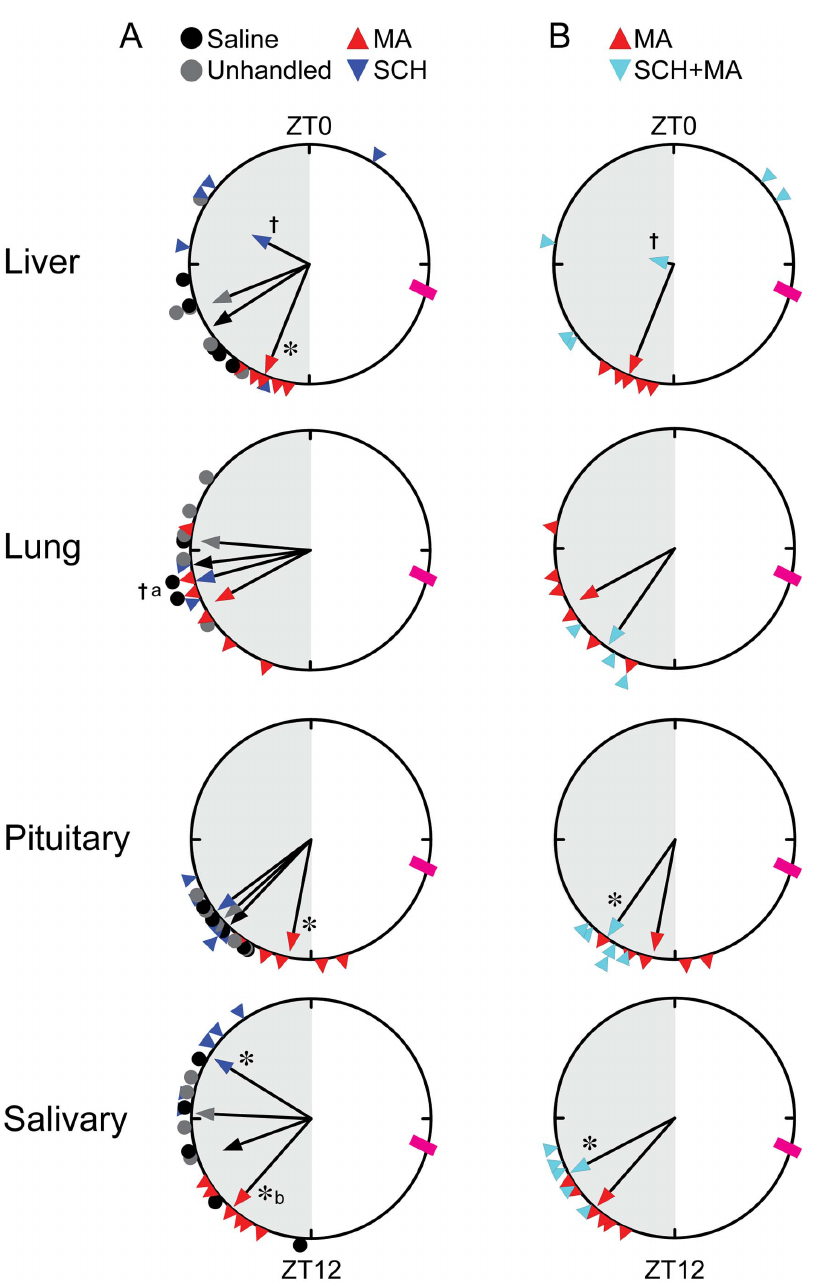
Figure 4. MA and SCH injections affect the phase of PER2::LUC expression in circadian oscillators. Rayleigh plots of the phases of peak PER2::LUC expression in liver, lung, pituitary gland, and salivary gland. Rayleigh plots can be read as a 24h clock, with ZT0 at the top and ZT12 at the bottom of the circle. Arrows represent the average peak phase of PER2::LUC expression (mean vectors for the circular distributions) of each group. The length of the vector represents the strength of the phase clustering while the angle of the vector represents the mean phase. Individual data points are plotted outside the circle. The pink box at ZT7 indicates the timing of MA injection for MA-treated groups. A) Data from groups that were saline-injected, unhandled, injected with MA (MA), or injected with SCH23390 alone (SCH). MA resulted in a significant phase advance in liver and pituitary gland (*, p , 0.05 compared to saline, unhandled, and SCH groups). In salivary gland, MA advanced phase relative to unhandled controls (*b, p , 0.05) whereas SCH significantly delayed phase compared to all other groups (saline, unhandled, or MA-injected). SCH administration resulted in desynchrony among livers ( { , Rayleigh p . 0.10). SCH administration also resulted in arrhythmicity in 4/6 lungs. Lungs from SCH-treated animals also failed to demonstrate significant synchrony ( { a, Rayleigh p . 0.10), although this was probably the result of decreased statistical power due to the low number of remaining rhythmic cultures. B) Data from groups that were pretreated with SCH before MA injection (SCH + MA) or injected with MA alone (same data as A). SCH pretreatment significantly attenuated the MA-induced phase shift in pituitary and salivary gland (*, p , 0.05) and disrupted synchrony among livers ( { , Rayleigh p . 0.10). SCH + MA also resulted in arrhythmicity in 2/5 lungs.